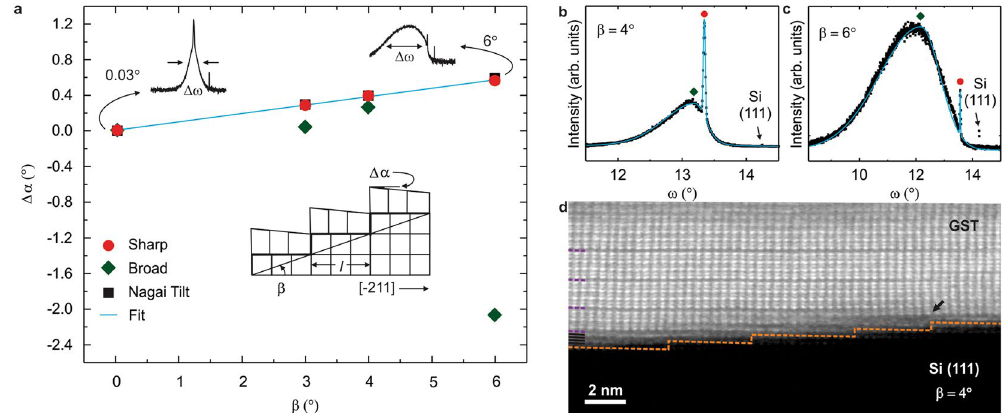
Figure 2. Evidence of strain in vdW bonded materials at the interface between substrate and epilayer. ( a ) Epitaxial orientation ( Δ α ) of the GST obtained from XRD rocking curves as a function of β . Two functions are adopted for the fit (red points and green rhombuses for the centers of the sharp and broad peaks, respectively). The Nagai model is represented by the black squares. The inset depicts the modified Nagai model where l is the average terrace width. ( b , c ) XRD rocking curves centered on GST (00.15) planes at Q z = 1.80 Å − 1 for β = 4 and 6°, respectively. The continuous light blue line is the fit. ( d ) Cross view [ − 211] high resolution HAADF-STEM micrograph for GST on Si (111) with β = 4°. The interface is highlighted by a dotted orange